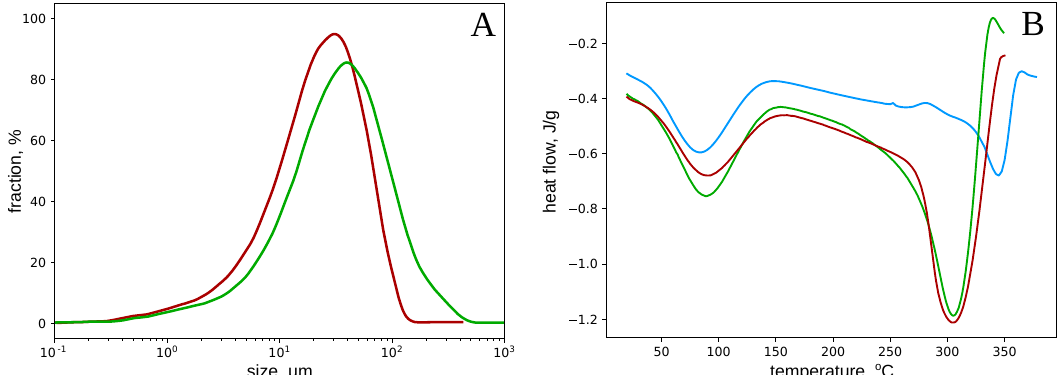
Figure 3. The size distribution of the MCC particles ( A ) and DSC-curves ( B ) for raw soft-wood cellulose (red line) and MCCs obtained after a single (green line) and double (red line) cycles of acid hydrolysis and subsequent